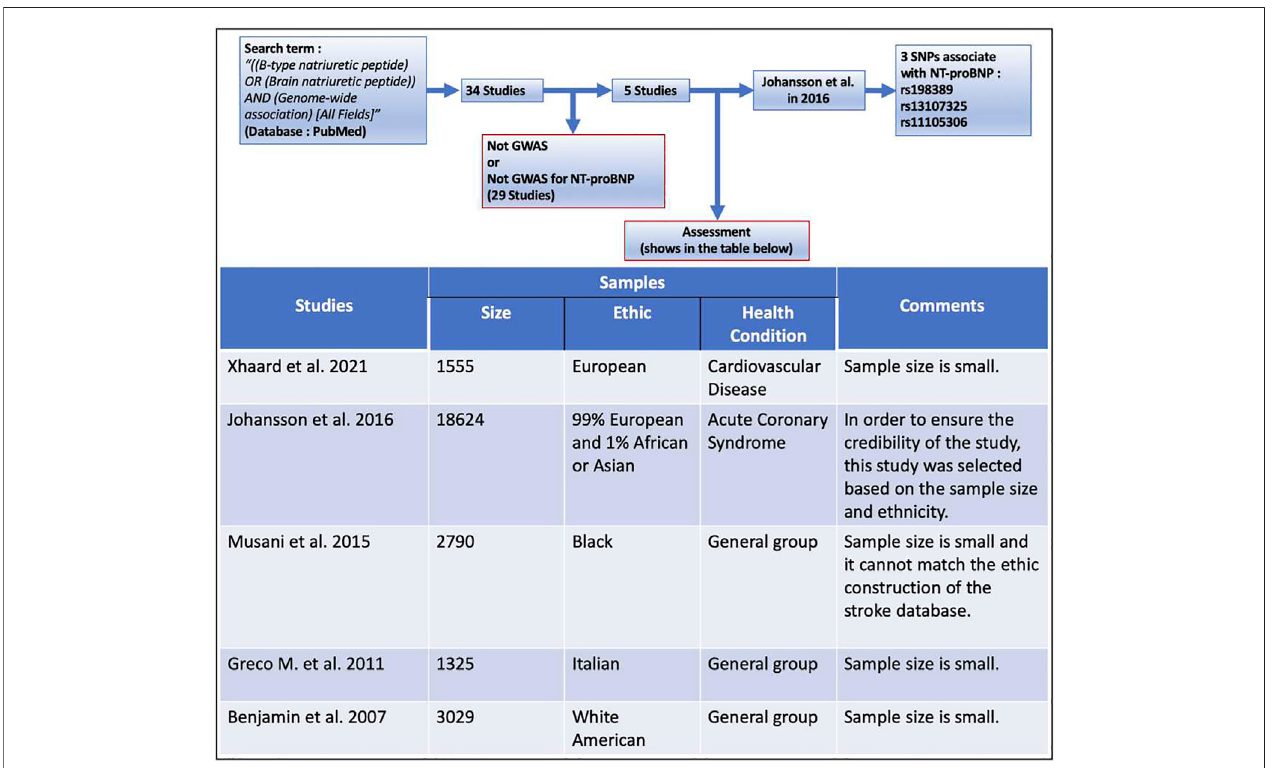
FIGURE 2 | The retrieval process and inclusion/discharge criteria of instrumental